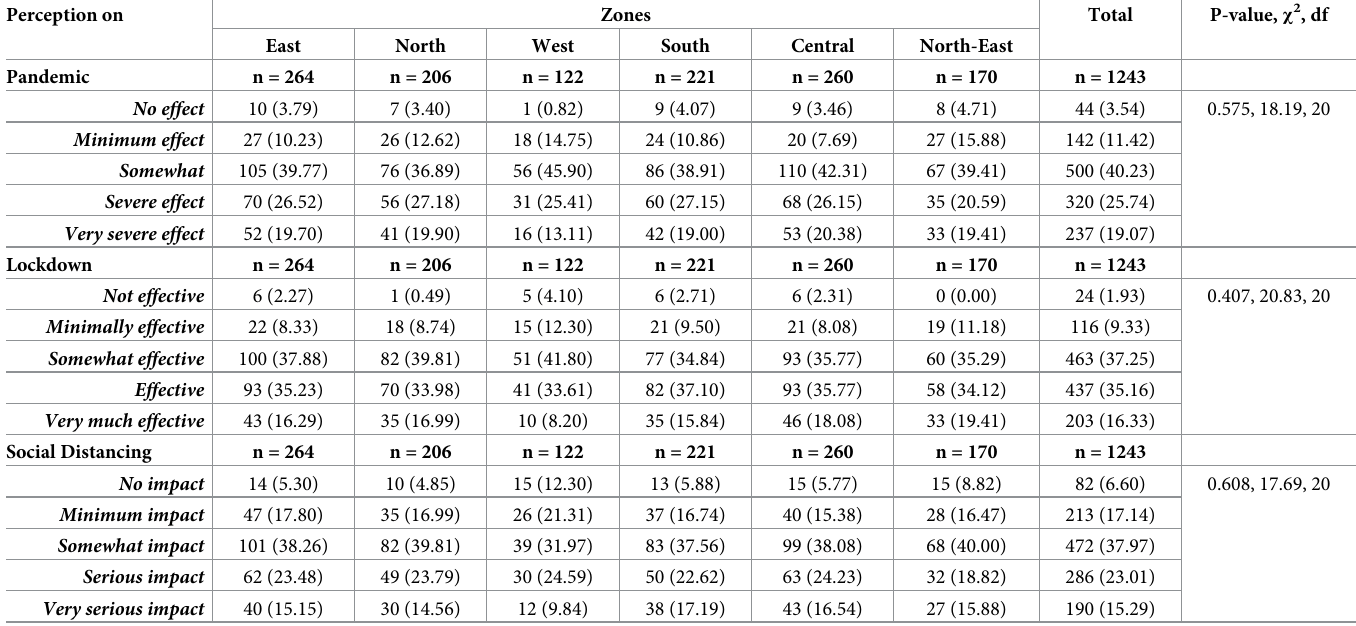
Numbers in the parentheses represent percentage values of the response categories within each zone/overall. χ 2 : Chi-square value for the test of trend within different zones, df: degrees of freedom.